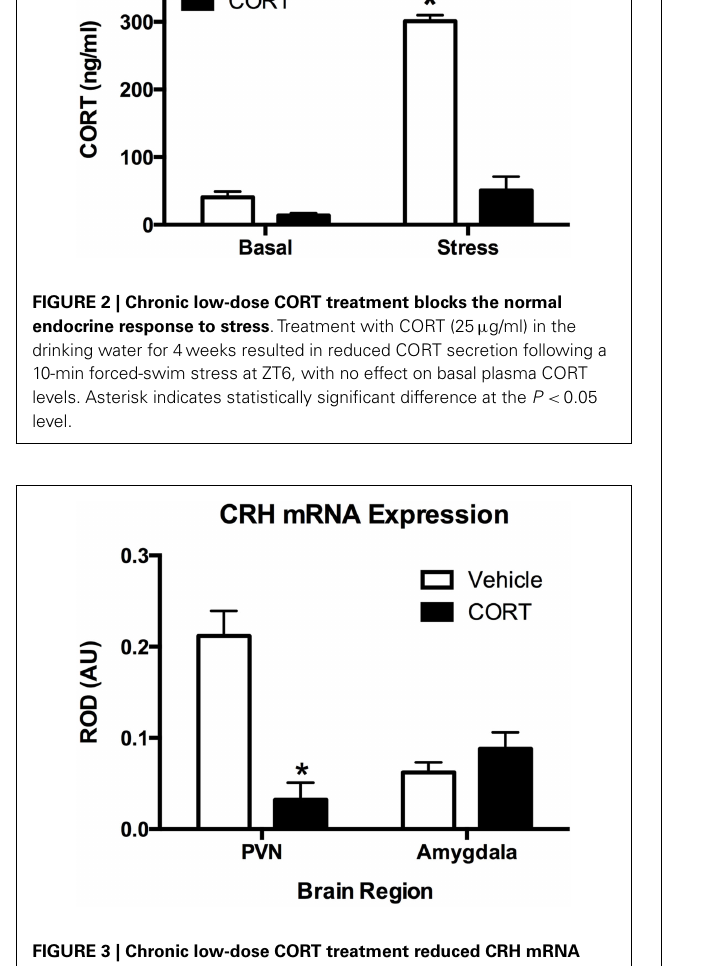
well as in the prefrontal cortex (PFC) 10 min after the